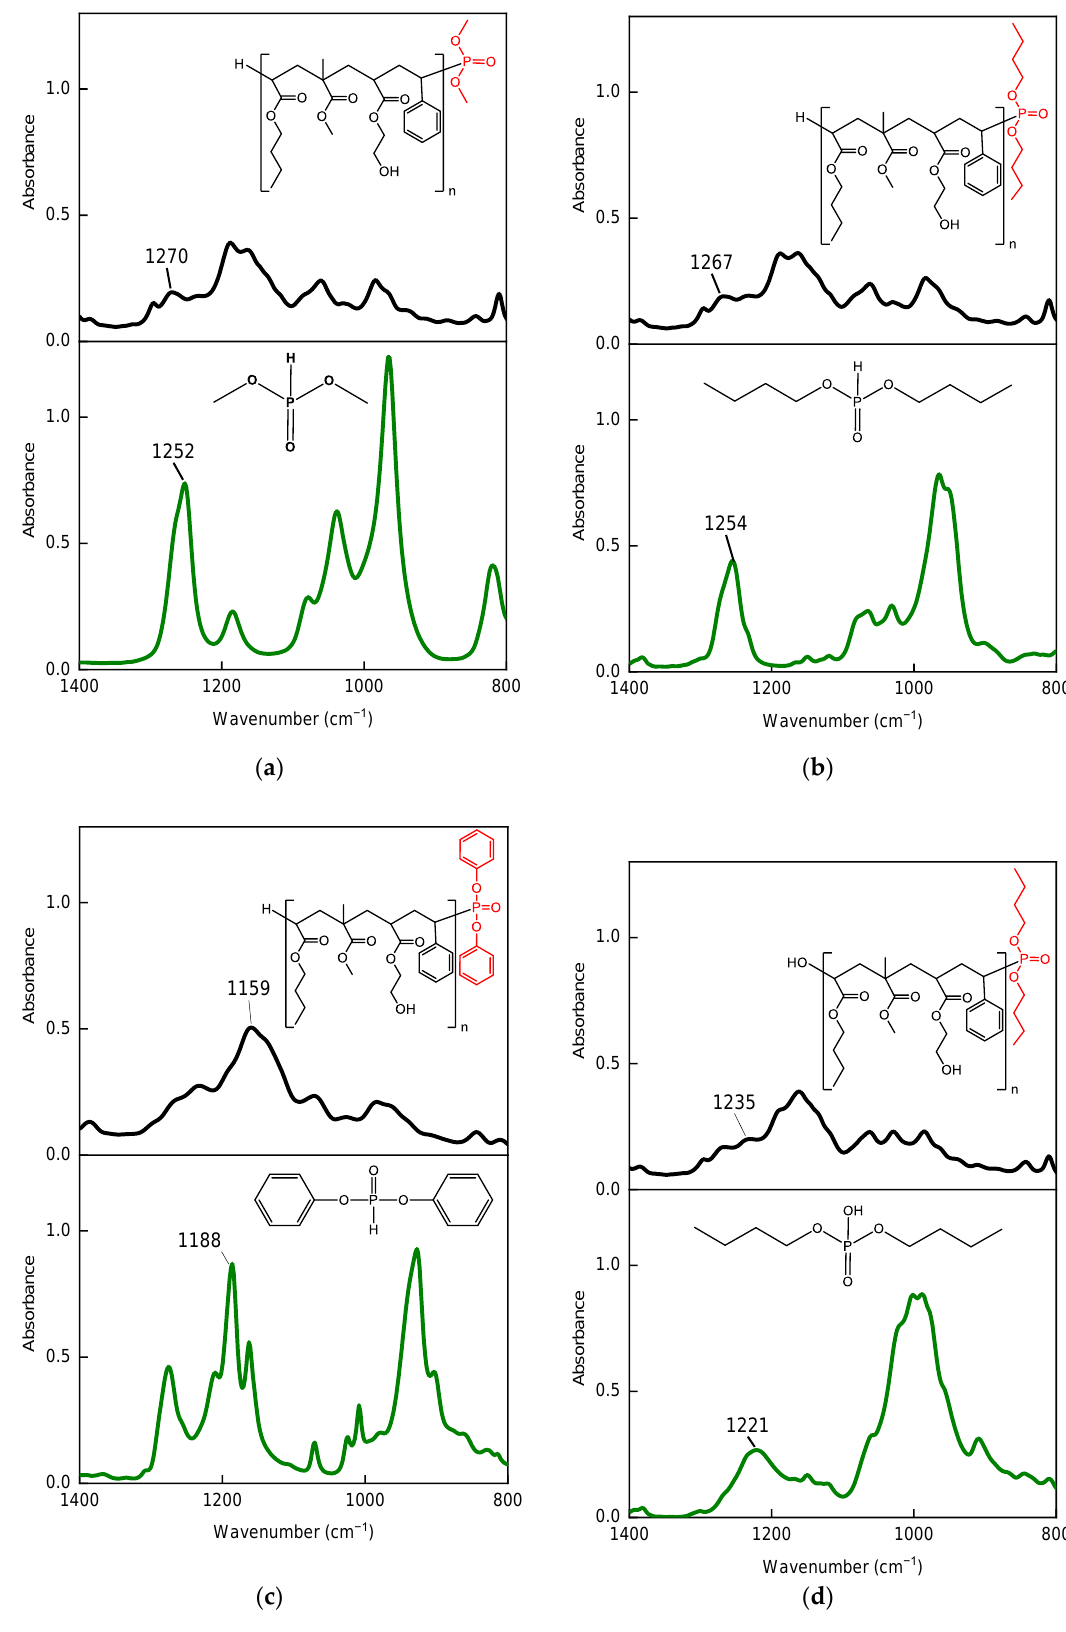
Figure 4. The FTIR spectra of: DMPh and P-DMPh telomer ( a ); DBPh and P-DBPh telomer ( b ); DPPh and P-DPPh telomer ( c ); DBP and P-DBP telomer ( d ).